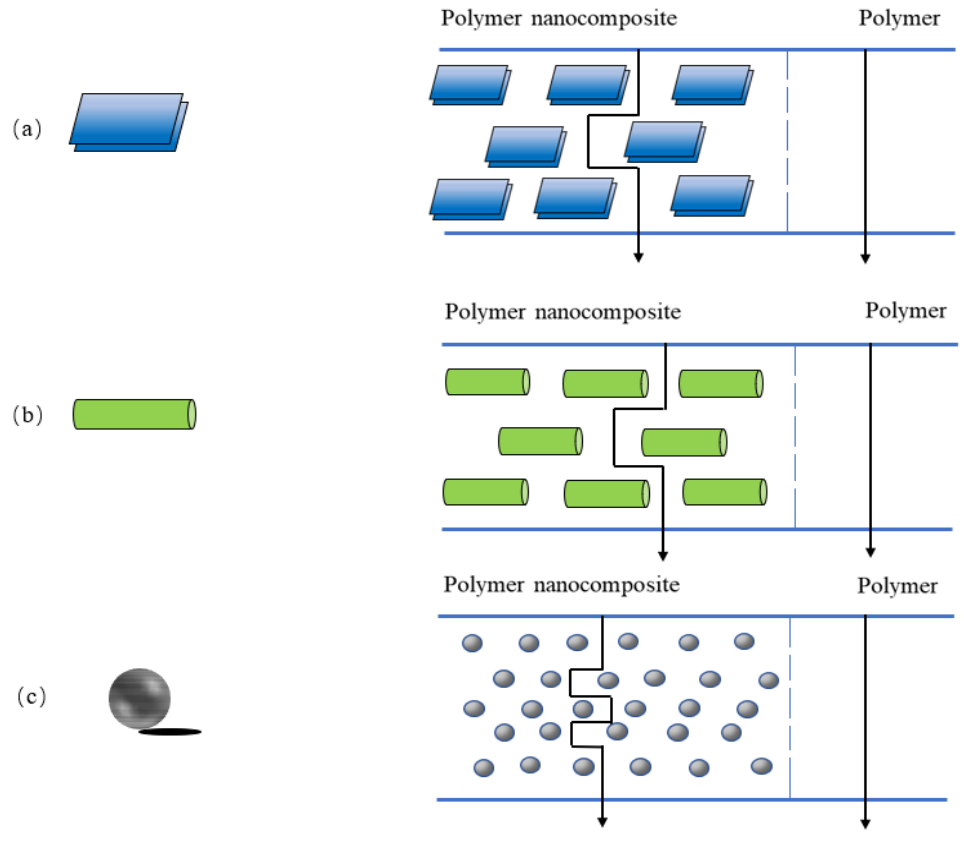
Figure 3. Schematic representation showing nanoparticle geometries and its corresponding tortuosity pathway in nanocomposites. ( a ) nanolayers, ( b ) nanotubes or nanofibers, ( c ) isodimensional na- noparticles.